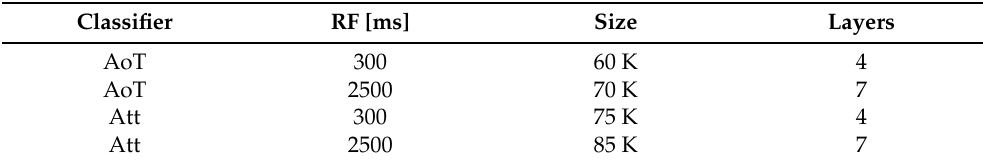
Table 1. Details of the evaluated models, average over time (AoT), and attention mechanism (Att). The number of layers refers only to convolutions.